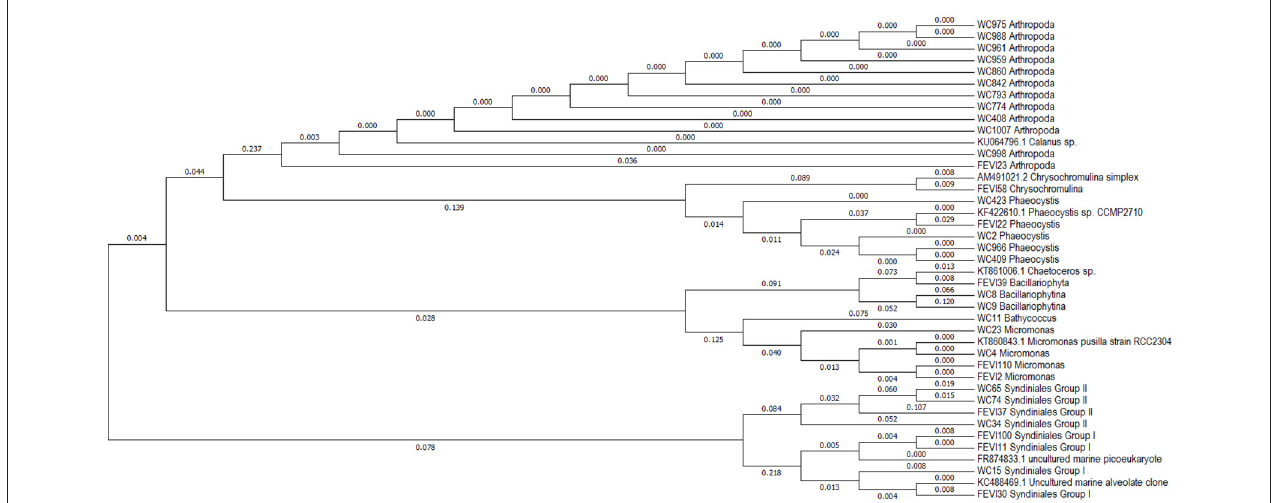
FIGURE 5 | Phylogenetic tree (maximum likelihood) of 18S rRNA gene sequences shared by the abundant biospheres of the samples collected via long-term sediment traps and in the DCM (Deep Chlorophyll Maximum) above the traps. Names of sequences starting with WC (Water Column) represent sequences originating from the DCM, while names of sequences starting with FEVI (acronym for proper name of traps) represent sequences originating from sediment traps. The number adjacent to FEVI and WC is the identifier of the OTU in the respective dataset. The numbers attached to the branches indicate sequence